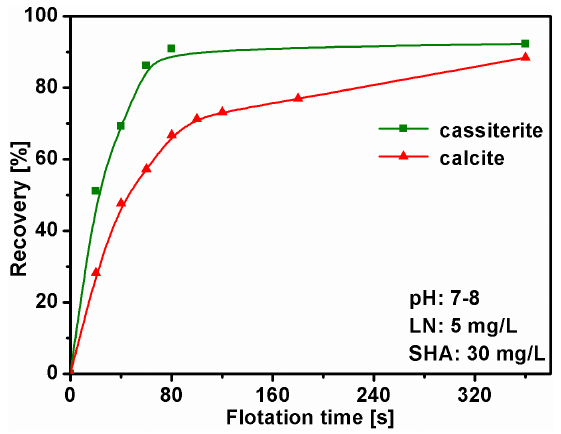
Figure 3. Recovery of cassiterite and calcite as a function of flotation time in the presence of 5 mg/L of LN and 30 mg/L of SHA.